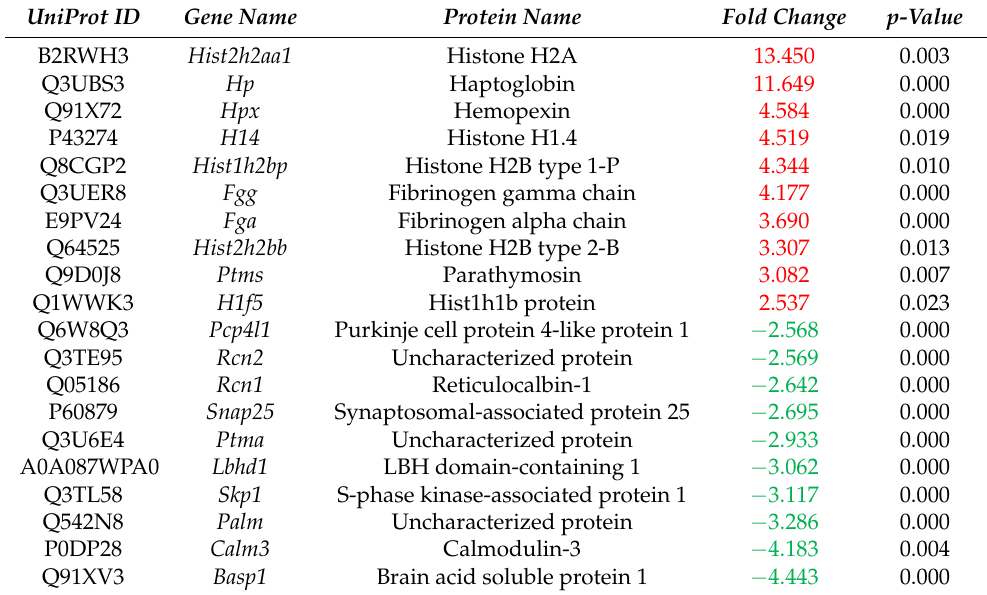
Table 1. Top 10 upregulated (red) or downregulated (green) DEPs.